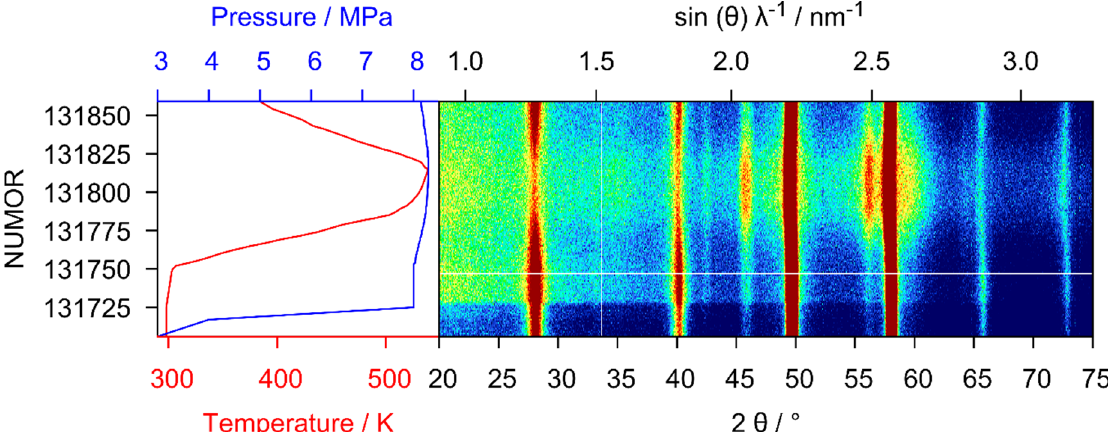
Figure 3. In situ neutron powder diffraction data (NUMOR 13,1706 − 13,1859 [21]) of the deuteration of ordered FePd 3 taken with diffractometer D20 (Grenoble, France) at λ = 186.80(2) Å in a single- crystal sapphire cell [19,20] under various temperature and deuterium pressure conditions. Intensities are in false colors.